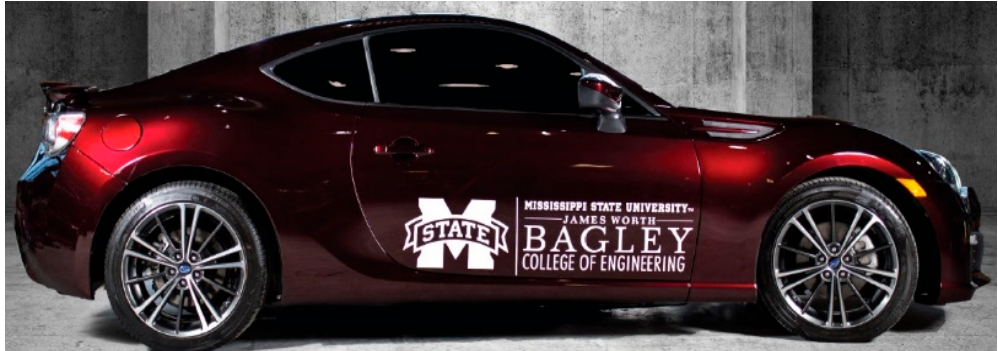
Figure 1. Picture of the car of the future plug-in series hybrid electric vehicle.